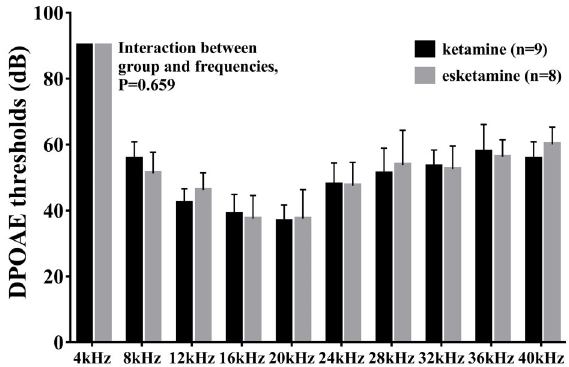
Figure 3. Esketamine did not affect outer hair cell function in mice. Distortion product otoacoustic emission (DPOAE) measure- ment showed that the function of outer hair cells was similar between the ketamine and esketamine groups. Data are reported as means ± SE. ANOVA was used to compare the